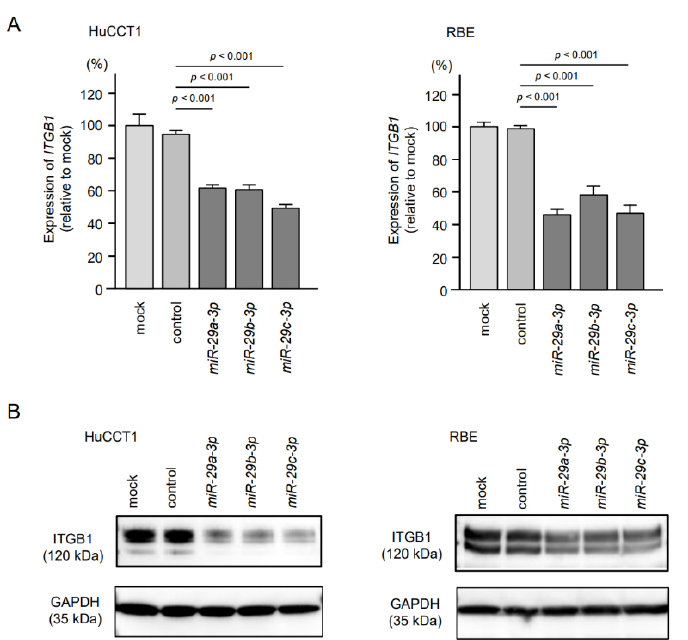
Figure 6. Regulation of ITGB1 /ITGB1 expression by ectopic expression of miR-29a-3p , miR-29b-3p and miR-29c-3p in intrahepatic cholangiocarcinoma (ICC) cells. ( A ) Expression levels of ITGB1 were significantly reduced by miR-29-3p transfection into ICC cells. GUSB was used as an internal control. ( B ) Protein expression levels of ITGB1 were significantly reduced by miR-29-3p transfection into ICC cells (72 h after transfection). GAPDH was used as an internal control.